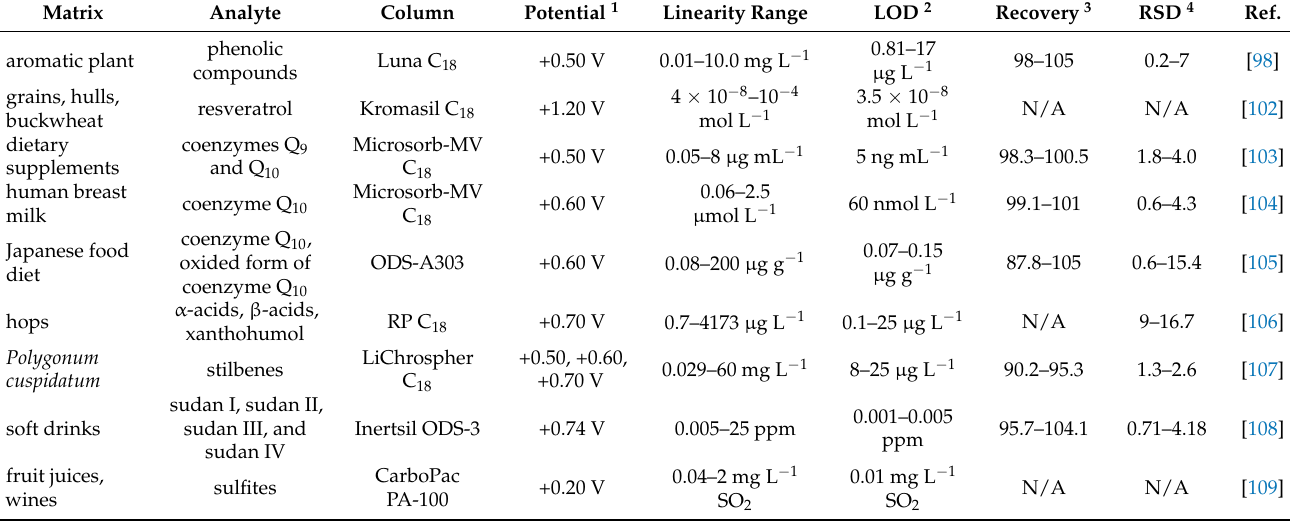
Table 9 resumes all the analytical data reported in the different studies discussed here. Table 9. HPLC-ED analysis performance in the analysis of different compounds in aromatic plants and other food matrices. The term “N/A” means the information is absent in the